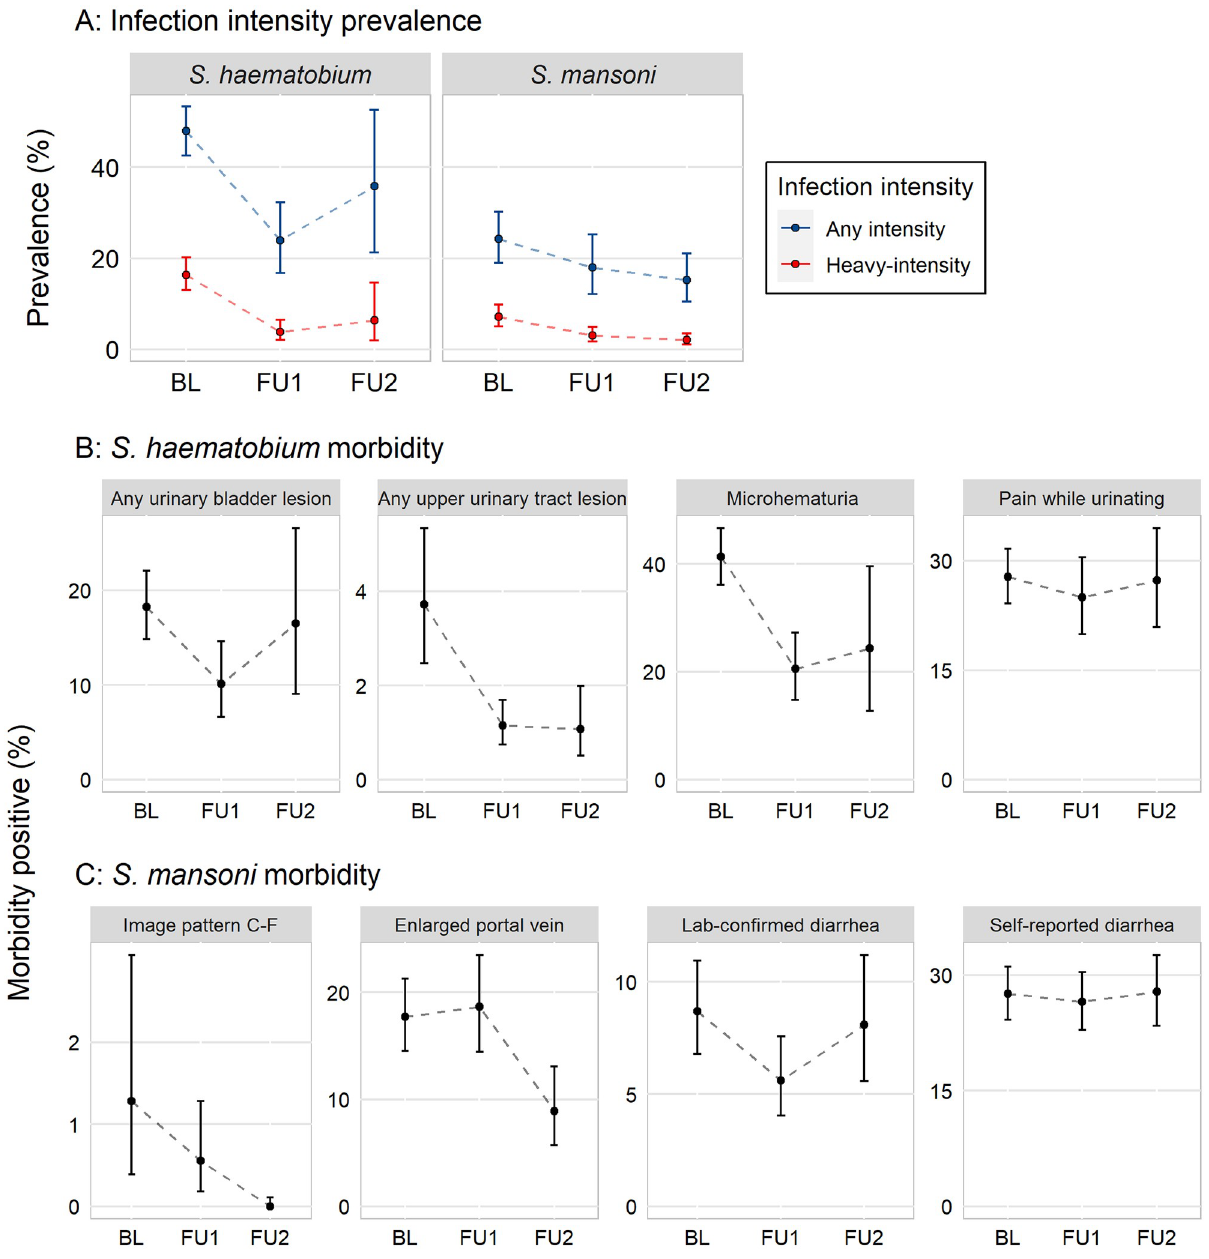
Fig 1. Line graphs of the percentage of 6- to 15-year-old children who were Schistosoma infection and heavy-intensity positive (row A), S . haematobium morbidity positive (row B), and S . mansoni morbidity positive (row C) at each survey year (baseline, BL; follow-up 1, FU1; follow- up 2, FU2). S . haematobium estimates are from Mali, Niger, and Tanzania and are assessed by urine filtration. S . mansoni estimates are from Mali, Niger, Tanzania, and Uganda and are assessed by the Kato-Katz